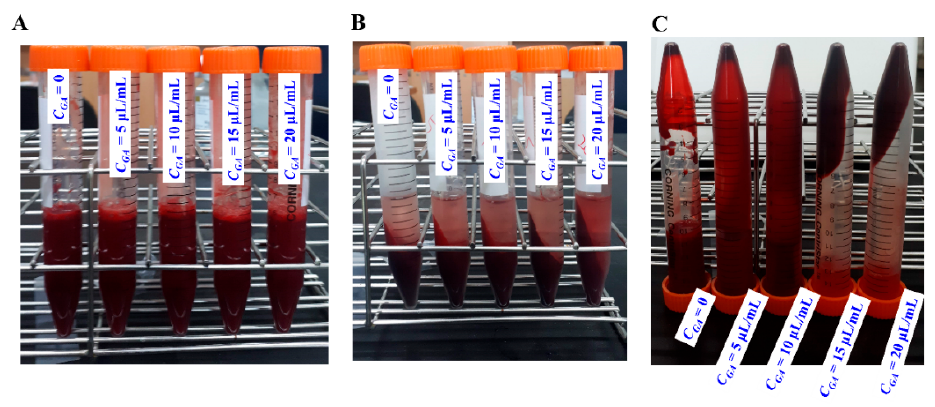
Figure A2. RBCs stacked and adhered to surface of tube after operating centrifuge. Blood sample ( Hct = 50%) was prepared by adding normal RBCs into a specific concentration of GA solution ( C GA = 0, 5, 10, 15, and 20 µ L / mL). ( A ) Tubes filled with blood samples before operating centrifuge. ( B ) Tubes filled with blood samples after operating centrifuge (4000 rpm x 10 min). ( C ) Inverted tubes filled with hardened blood samples with respect to C GA . Above C GA = 15 µ L / mL, hardened RBCs adhered to the surface of tubes, and it was difficult to collect hardened RBCs from the tube.